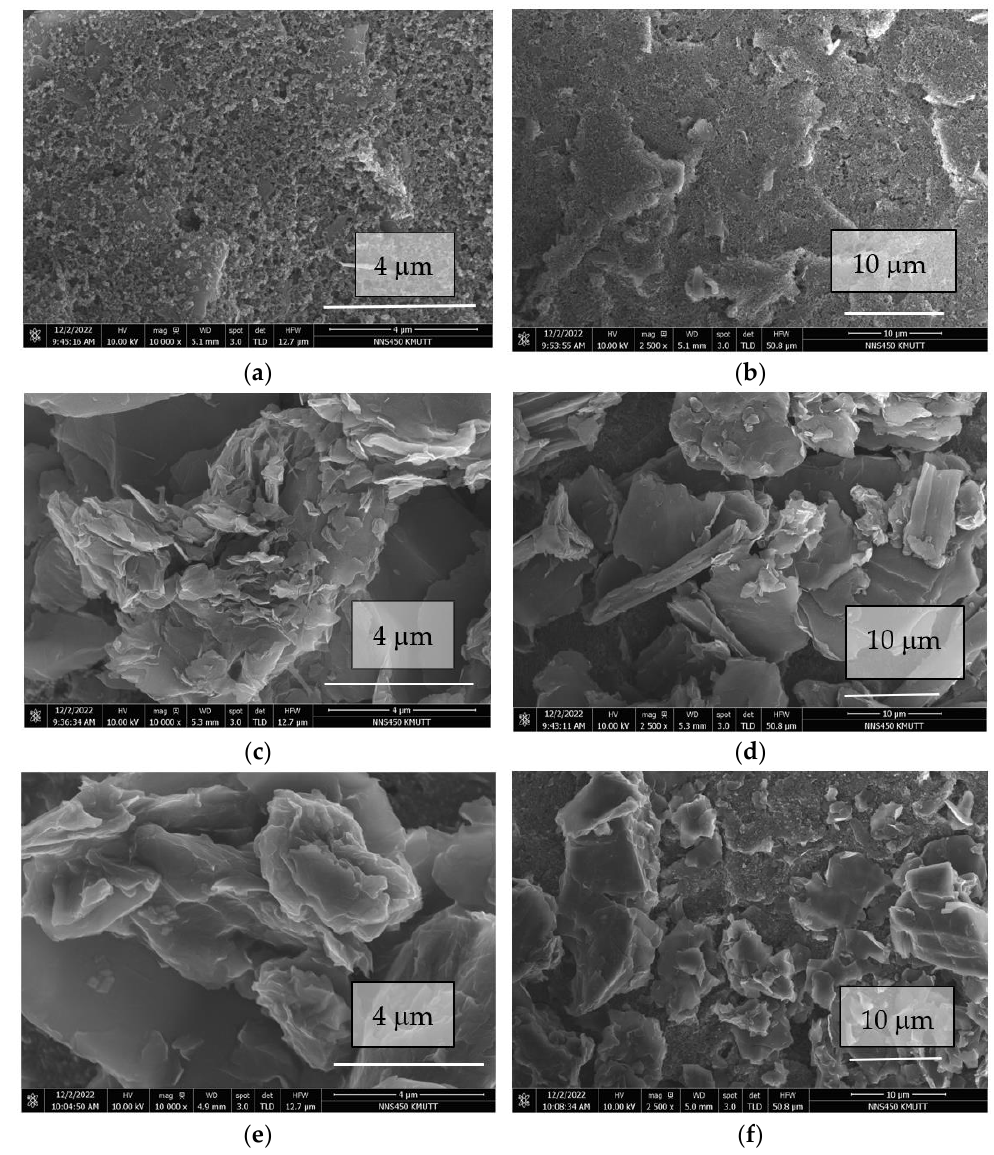
Figure 2. SEM images of unmodified SPCE ( a , b ), modified MP/GP nanohybrids on SPCE ( c , d ), and modified MP/GP nanohybrids on SPCE that was scanned by CV for 100 cycles ( e , f ). X-ray photoelectron spectroscopy of MB/GP before and after the 10 cycles of CV scanning was measured to achieve insight into the adsorption capacity of MB on the produced electrode. Three peaks that matched the C-C (284.8 eV), C-N (285.4 eV), C-O (286.6 eV), and O-C=O (288.9 eV) peaks were fitted into the C 1s XPS spectra of MB/GP (Figure 3a) [45,46]. Due to contributions from nitrogen species, a fine scan for N 1s revealed a broad and symmetric signal (Figure 3b). Peak fitting analysis revealed binding energies of 399.9 eV, which were attributed to the C-N groups [47]. In the S 2p spectra shown in Figure 3c, two sulfur-related peaks were found at 164.6 eV (S 2p 3/2 ) and 168.0 eV (S 2p 1/2 ). These two peaks should be assigned the sulfur of the phenothiazine structure in MB [48]. As a result, the XPS data suggested that MB was successfully adsorbed onto the electrode. After the 10th cycle of CV scanning, the C-1s, N-1s, and S-2p XPS spectra of the MB/GP-10th cycle were well matched to that of the as-prepared electrode, suggesting that the MB is stable under CV measurement (Figure 3d–f).